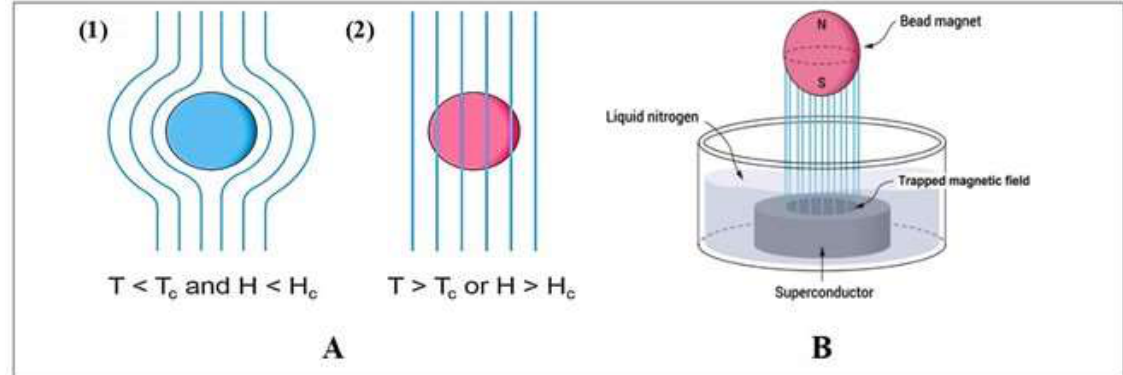
Figure 2: A-Magnetic fields in (1) Superconductor state (2) Conductor state, and B- the Meissner effect [13].